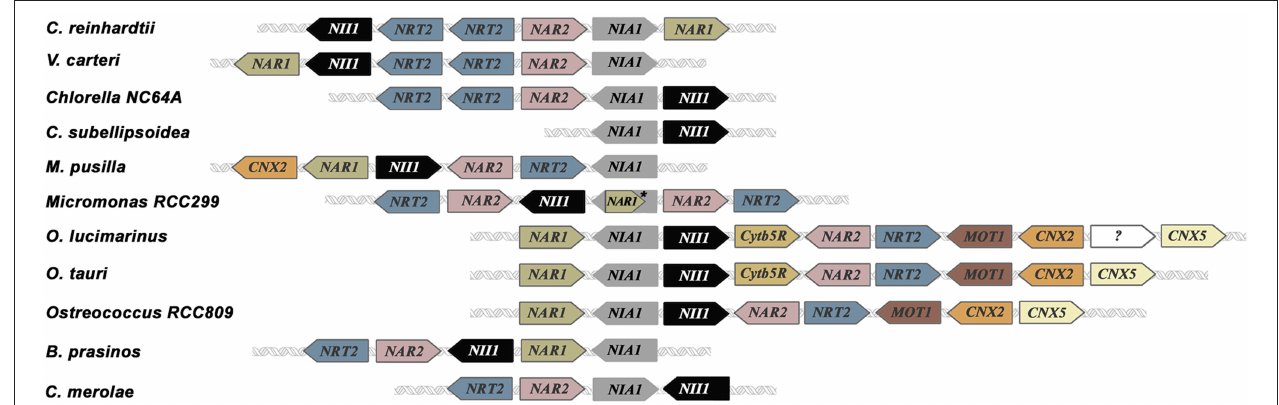
FIGURE 2 | Clusters of nitrate assimilation genes in microalgae. NIA1 and NII1 (genes encoding NR and NiR) are the only genes conserved in all clusters represented. All clusters have been arranged to show NIA1 gene fixed in the middle of the figure. All the genes represented are involved in nitrate assimilation and molybdenum metabolism with exception of Cytb5R whose relationship with nitrate metabolism is unknown. * In Micromonas RCC299 NIA1 and NAR1 are